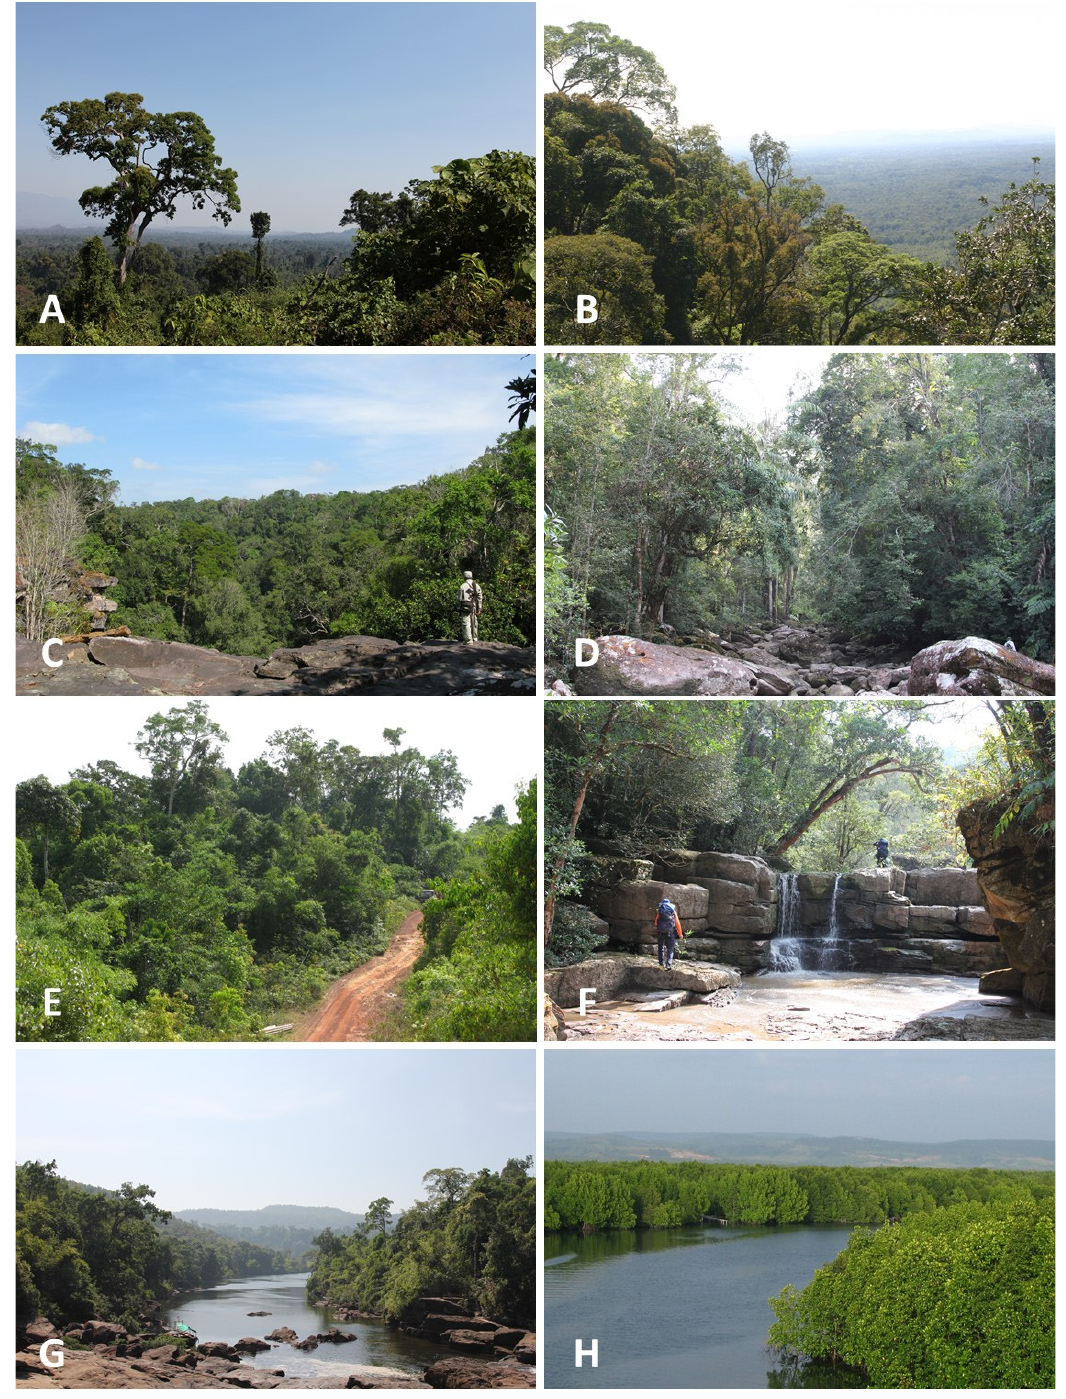
Figure 2. Landscapes of field trips in Cambodia. ( A ) Mt. Samkoh in Pursat Province; ( B ) Virachey National Park in Rattanakiri Province; ( C ) Rainforest at Bokor National Park in Kampot Province; ( D ) Rainforest at Bokor National Park in Kampot Province; ( E ) Dry forest at Srae Ambel District in Koh Kong Province; ( F ) Small waterfall and cliffs in Bokor National Park in Kampot Province; ( G ) Riverbank of Tatai river in Koh Kong Province; ( H ) Mangrove forest in Koh Kong Province (Photo by S.S. Choi, 2009–2013).